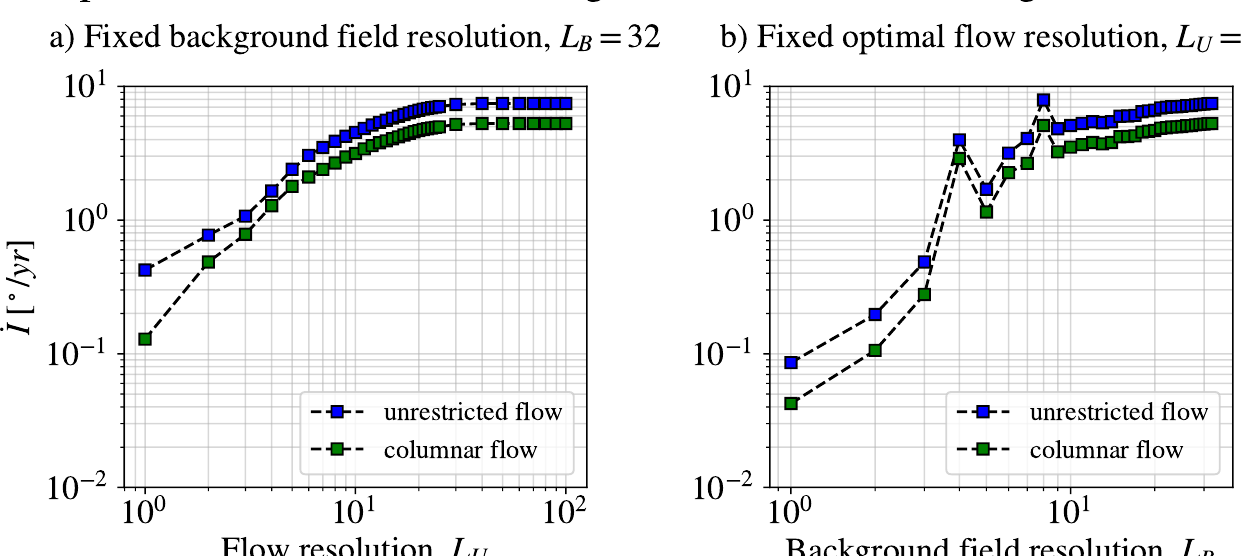
Figure 6. Convergence study for the optimal calculation of the inclination rate of change with the Rm = 450 geodynamo simulation from [26]. The panels show the optimal inclination variation at the location marked by the yellow star in Figure 5, varying the spatial resolution of the fluid flows ( a ) and the spatial resolution of the background magnetic field ( b ). In all cases, the rms flow speed is fixed at T 0 = 1.45 km/y, the same value used for the results presented in Figure 5, for L B = 32 and L U =